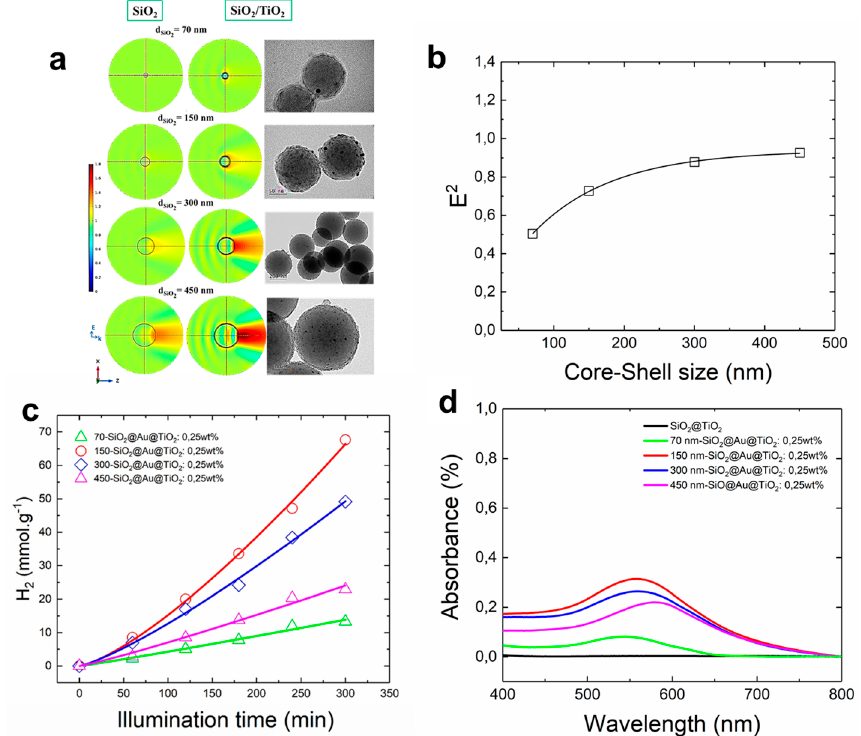
Figure 10. ( a ) Complex electric field distribution patterns for different diameters of silica core before (SiO 2 ) and after (SiO 2 @TiO 2 ) shell coating and their correspondent TEM images; ( b ) the squared electric field amplitude evolution vs. the core–shell size averaged over the plasmonic core–shell nanostructure; ( c ) the photocatalytic hydrogen generation under UV visible light irradiation for variable size of the core–shell plasmonic nanostructure (70 to 450 nm); ( d ) UV visible absorption spectra of plasmonic core–shell with variable silica core